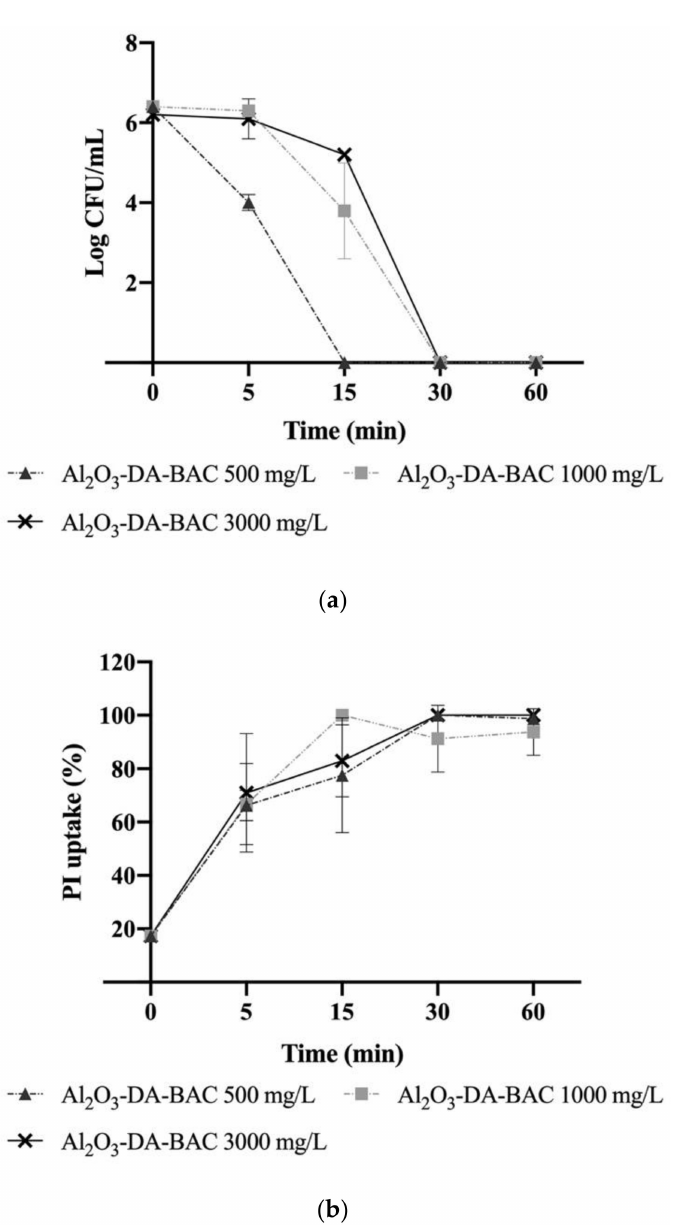
Figure 7. Logarithm of the colony forming units per milliliter (CFU/mL) ( a ) and propidium iodide (PI) uptake (%) ( b ) of Escherichia coli planktonic cells exposed to functionalized particles over time after reuse. The overall tested concentrations were: 500, 1000 and 3000 mg/L. Error bars correspond to the standard deviation of the mean determined for two independent